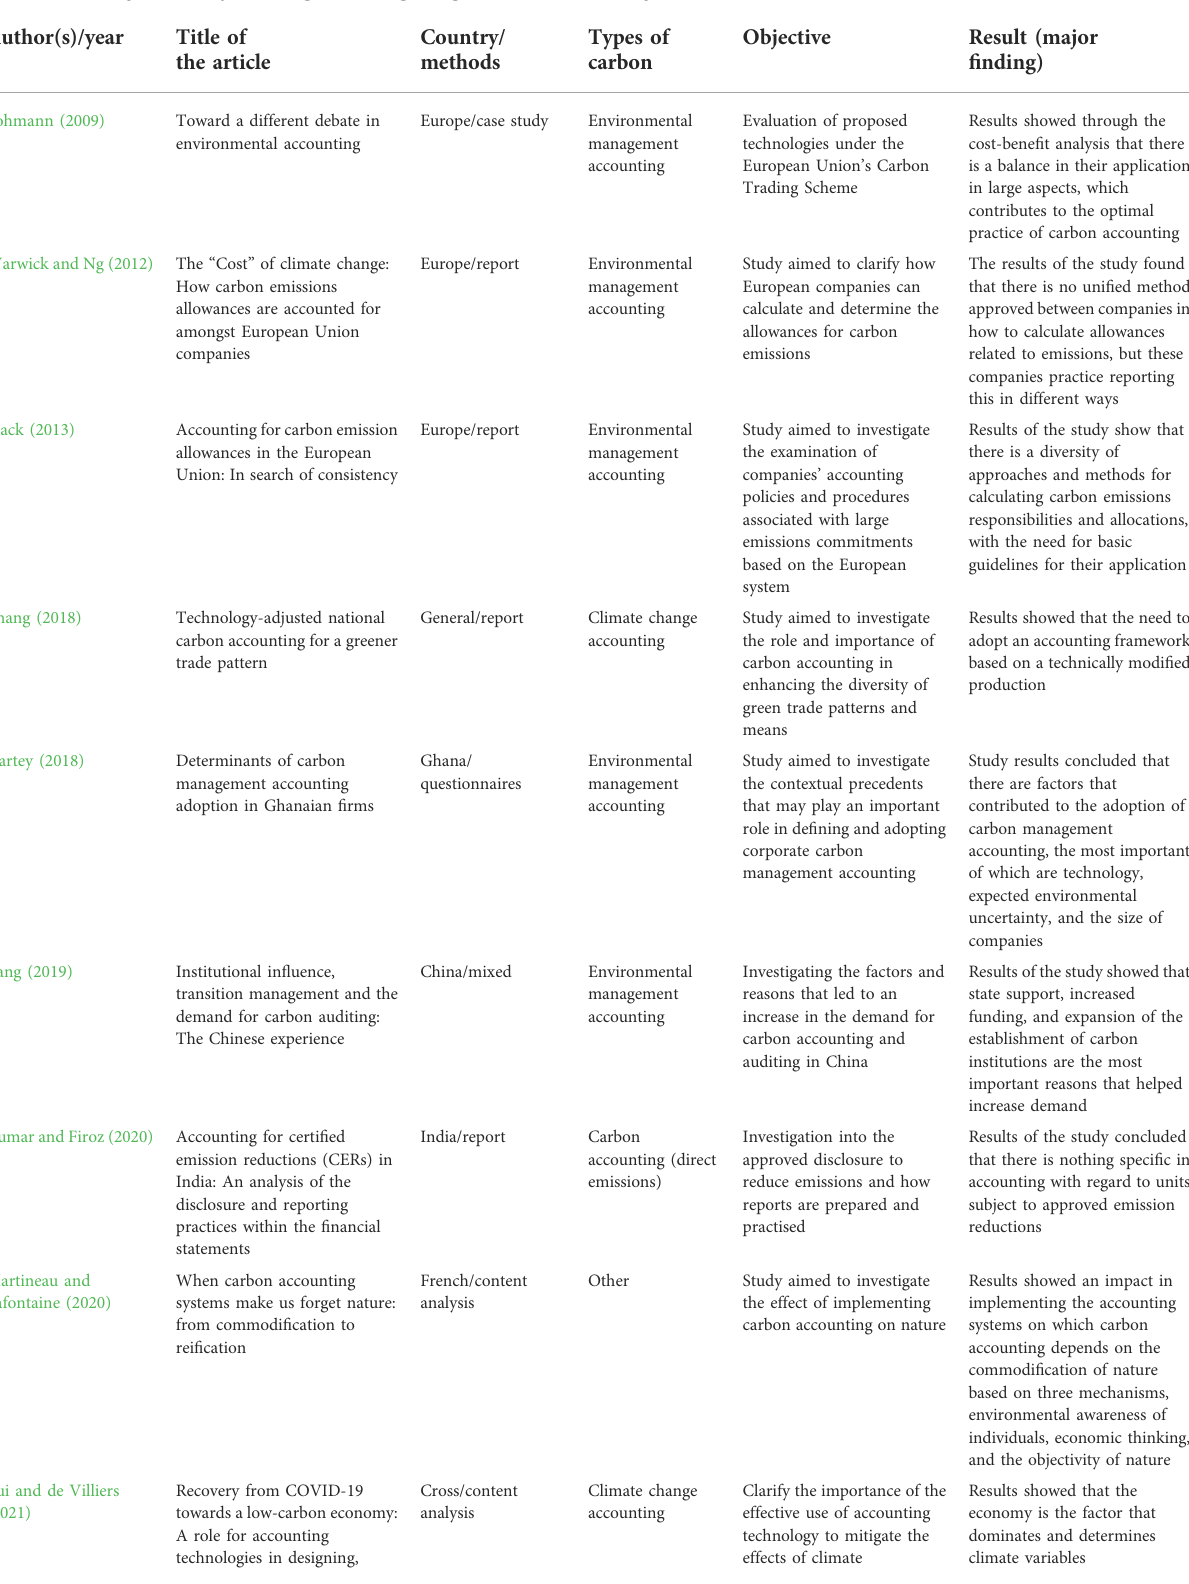
TABLE 3 Summary of the major existing studies regarding national scale 13